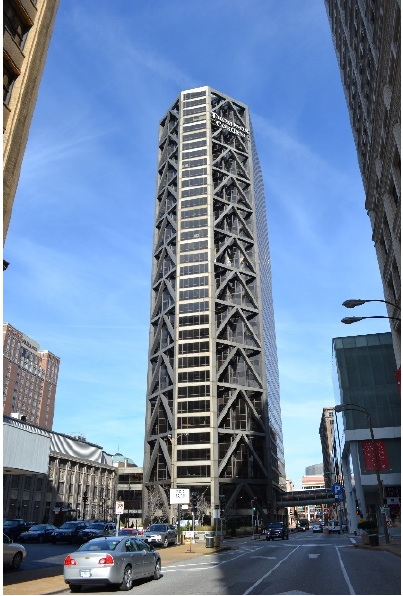
Figure 19. One US Bank Plaza (1976) in Saint Louis, Missouri. (Photo by K. Al-Kodmany).